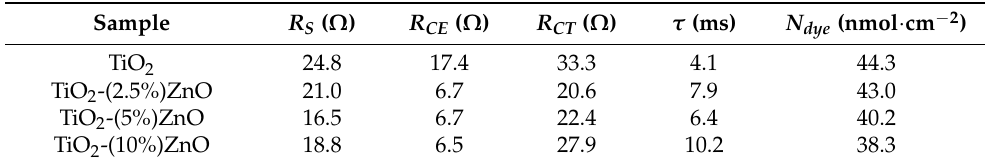
Table 7. EIS parameters and the amounts of adsorbed dyes’ molecules of DSSCs utilizing TiO 2 - ZnO photoanodes.